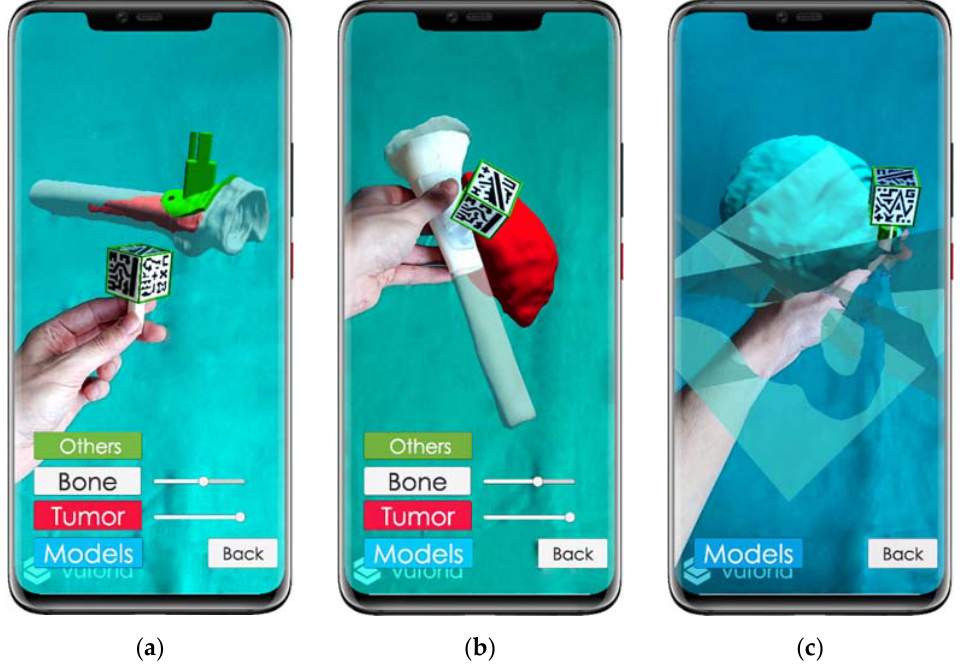
Figure 4. ARHealth smartphone application. ( a ) Demo mode using patient AR3DP0005 3D models, tumor is represented in red inside the bone, which is displayed in white with transparency texture; ( b ) Virtual visualization (tumor in red, bone in white with transparency texture) overlaid on top of the 3D-printed bone fragment (solid white) of patient AR3DP0007 using Clinic mode; ( c ) Surgical mode visualization of patient AR3DP0004 (tumor is represented in blue and cutting planes in semi- transparent green). A green frame surrounding the AR marker indicates that the reference is being tracked by the system